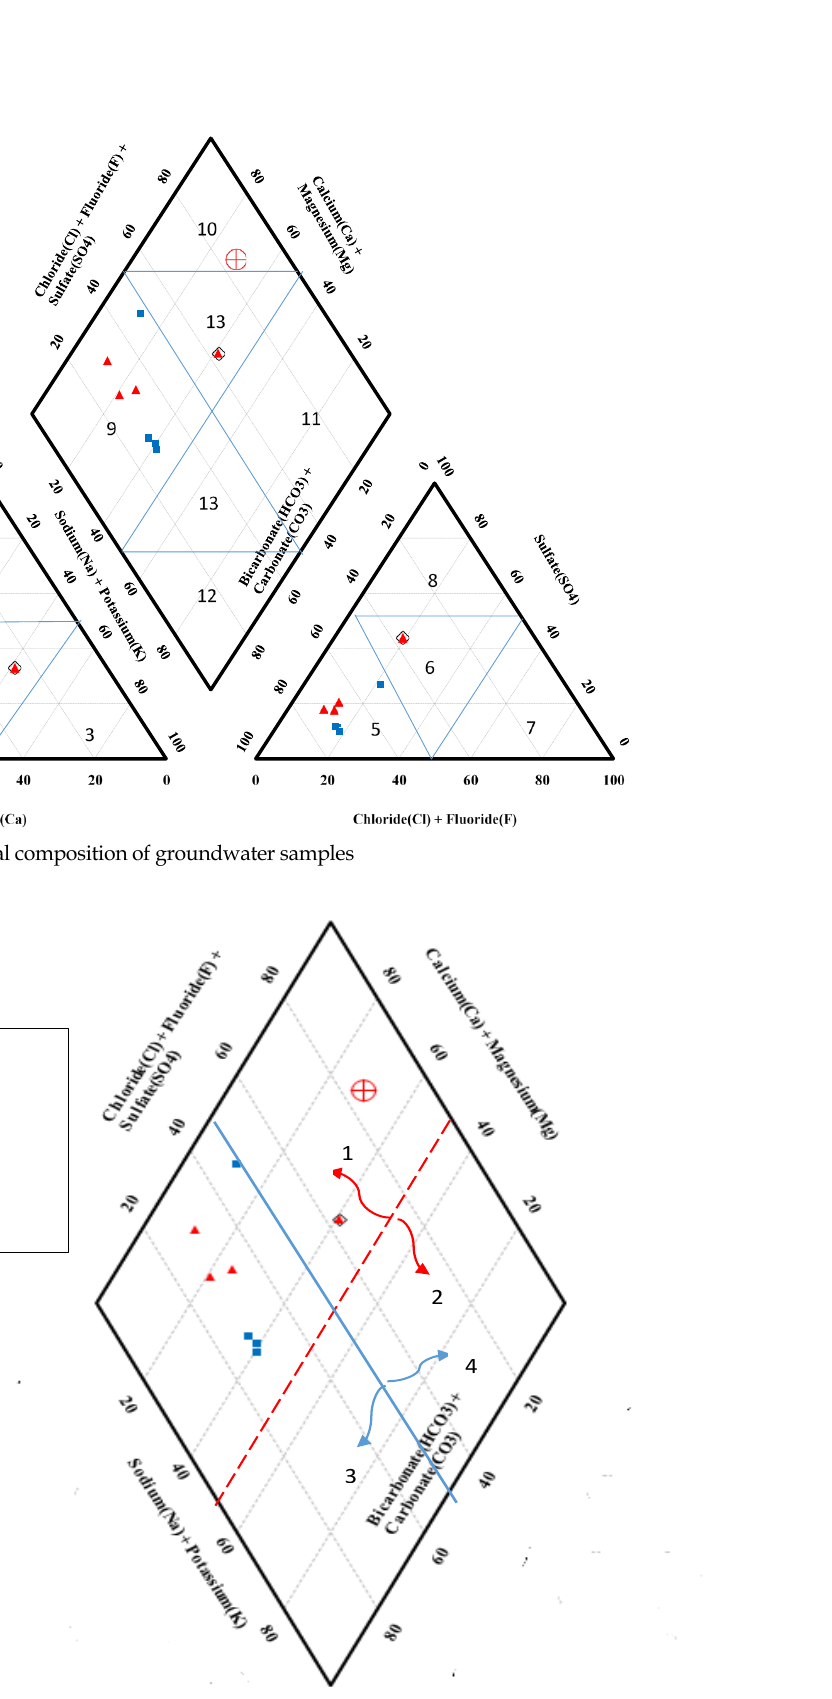
Figure 5. Hydrochemical facies plot illustrating the principal geochemical process in the study area